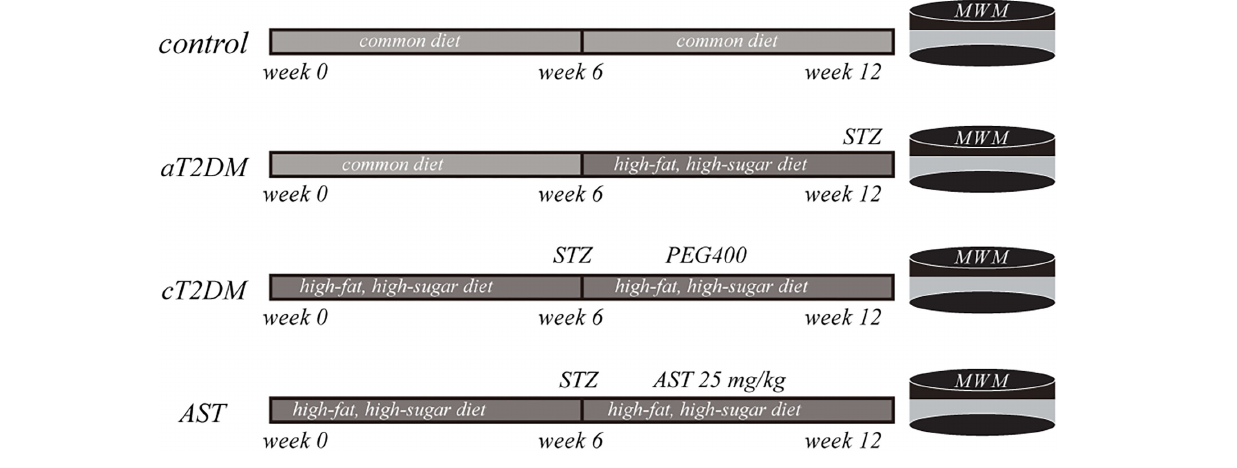
FIGURE 1 | A schematic flow chart exhibiting the experimental paradigm of the present study. aT2DM, acute type 2 diabetes mellitus; cT2DM, chronic type 2 diabetes mellitus; AST, astaxanthin. WMM: Morris water maze; STZ: streptozocin; PEG400: polyethylene glycol